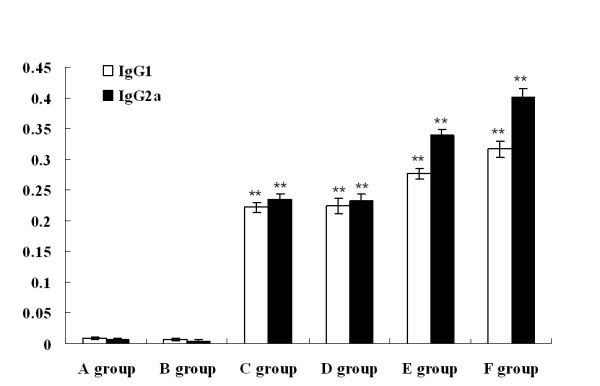
The subclasses IgG1 and IgG2a of anti-ORFV IgG antibodies in the serum samples of immunized mice of different groups. Sera were taken from immunized mice of different groups 1 week post the final boost immunization. The titration of ORFV-specific immunoglobulin (IgG) subclasses 1 and 2a was detected by ELISA. As shown in Figure 4, the assay of IgG2a and IgG1 antibodies performed at 1 week post the final boost immunization indicates a significant difference between vaccine plasmids groups (including pcDNA 3.1-ORFV011 group, pcDNA 3.1-ORFV059 group, pcDNA3.1-ORFV011 plus pcDNA3.1-ORFV059 group and pcDNA3.1-ORFV011/ORFV059 group) and control groups (including PBS and pcDNA3.1(+) group) (**P < 0.01). A group: PBS; B group: pcDNA3.1(+) vector; C group: pcDNA3.1-ORFV011; D group: pcDNA3.1-ORFV059; E group: pcDNA3.1-ORFV011 plus pcDNA3.1-ORFV059; F group: pcDNA3.1-ORFV011/ORFV059.